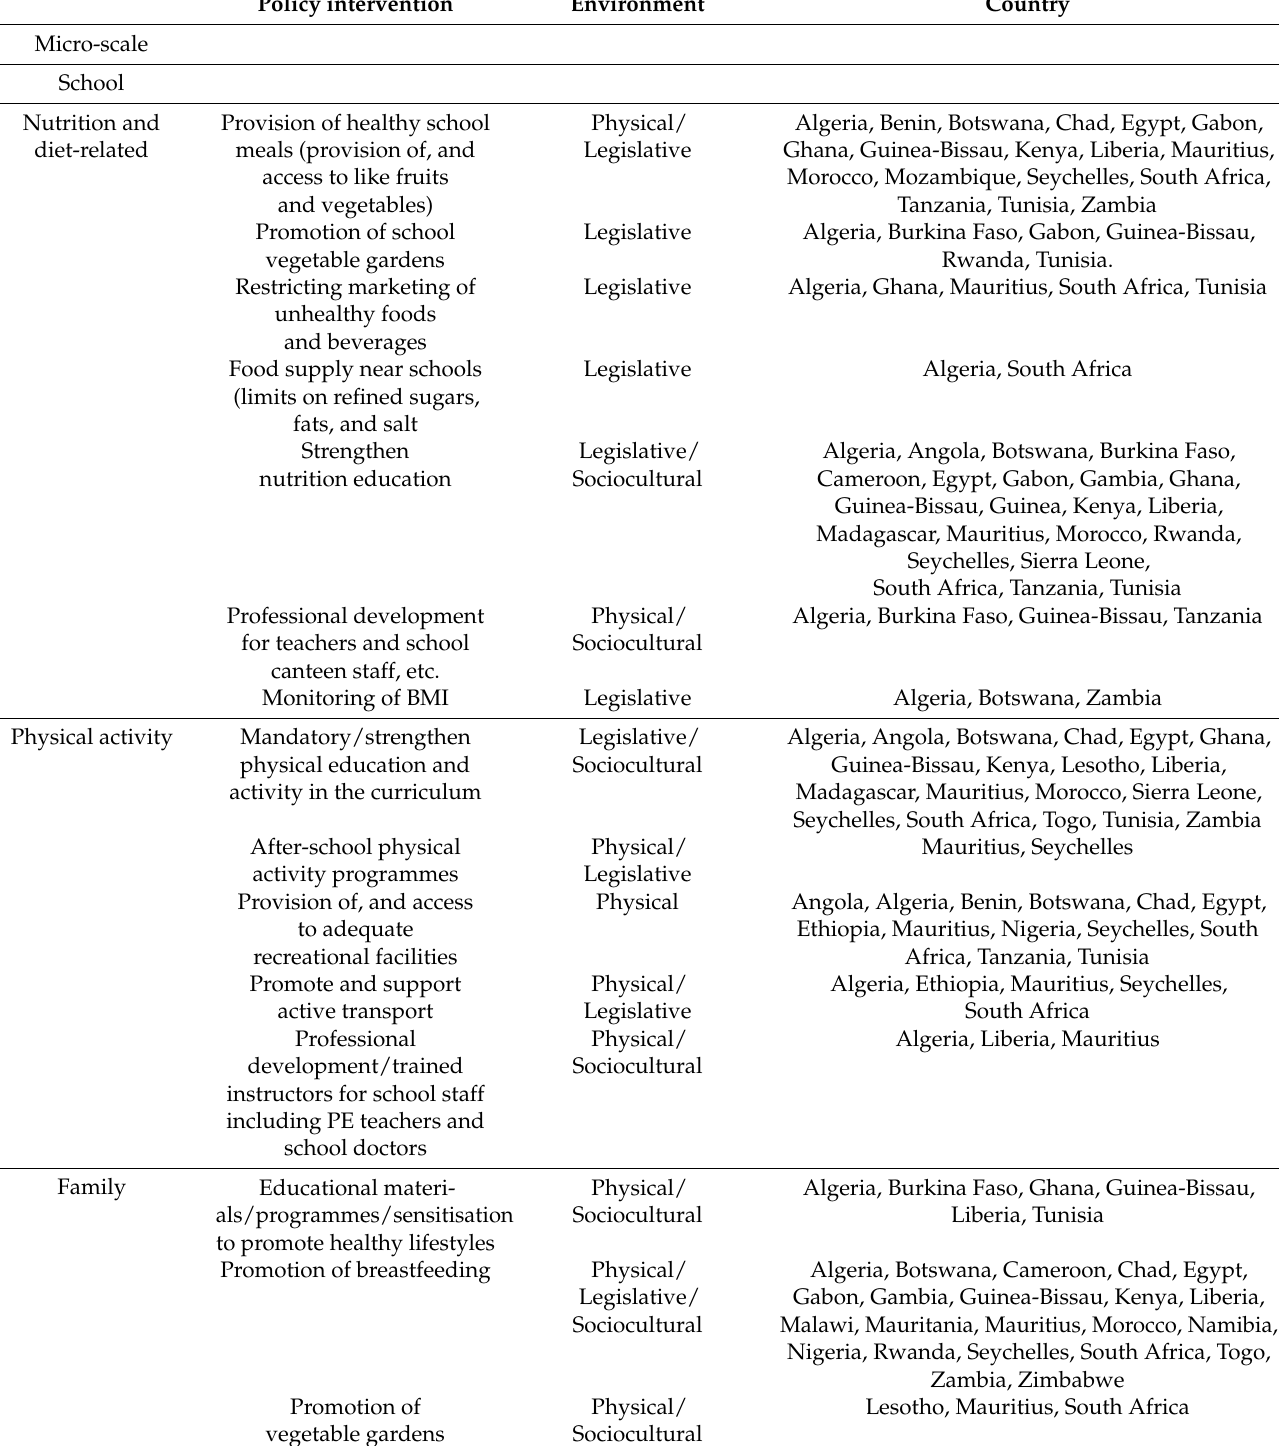
Table 2. Categorisation of key policy interventions related to unhealthy diets, physical inactivity, and overweight/obesity